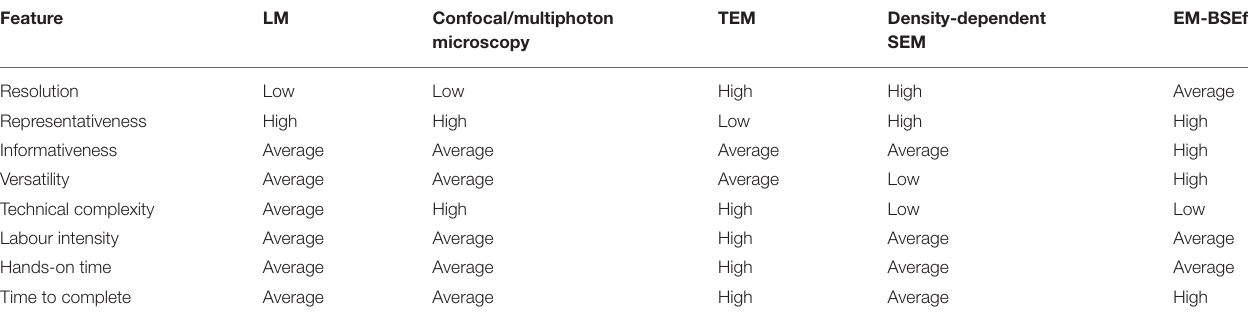
TABLE 4 | Comparison of light microscopy (LM), EM-BSEM, and transmission electron microscopy